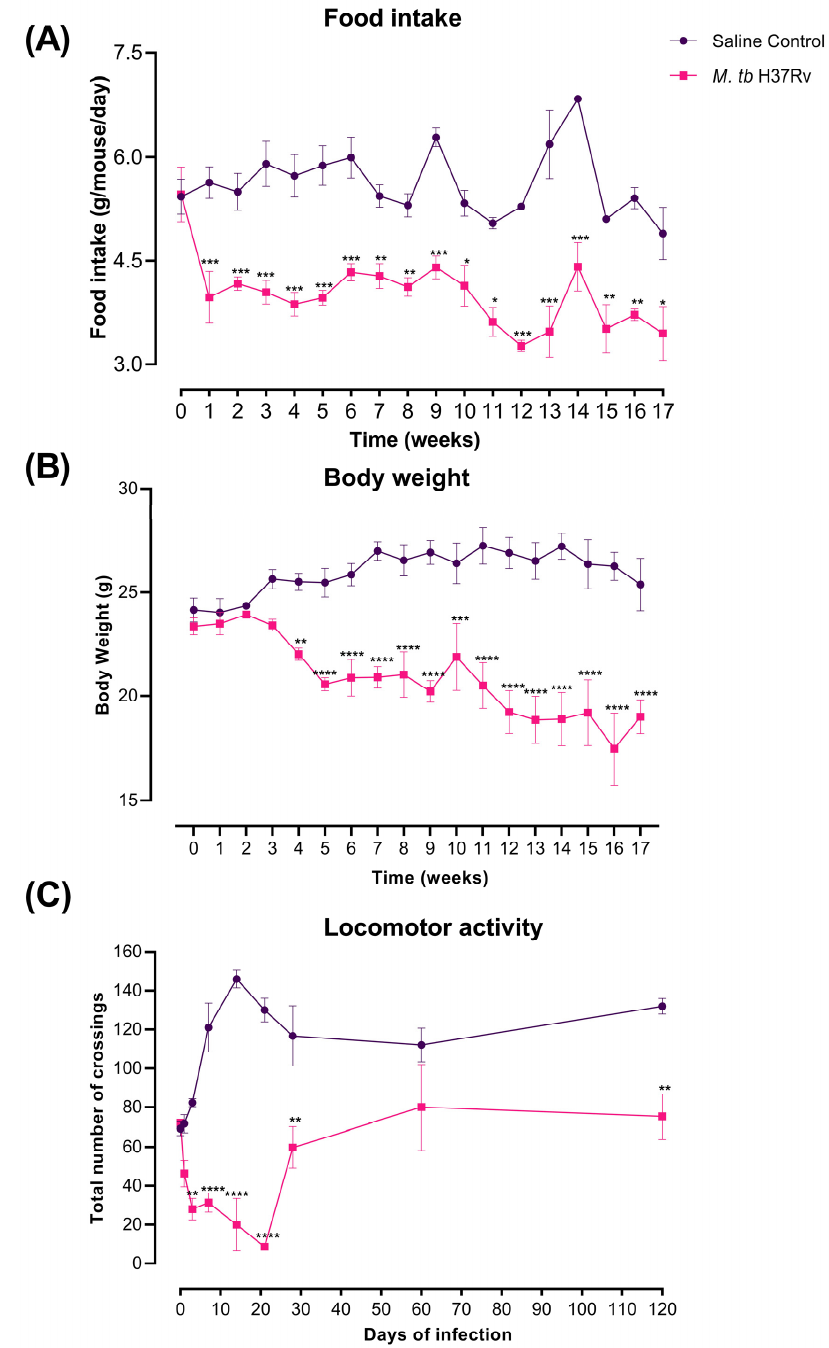
Figure 13. Sickness behaviour showed by TB mice. ( A ) Food intake, ( B ) body weight loss and ( C ) locomotor activity (LMA). Infected animals showed food intake decrease after one week of infection, Body weight starts decreasing after three weeks post-infection, and the locomotor activity was decreased during the whole course of the disease being most pronounced during early infection from day 1 to 21. Data are expressed as mean ± SEM. Food intake F (1, 10) = 51.86, p < 0.0001, two-way ANOVA; * p < 0.01, ** p < 0.001, *** p < 0.0005, Sidak’s multiple comparisons test ( α = 0.05) ( n = 6). Body weight loss F (1, 3) = 101.2, p = 0.0021, two-way ANOVA; ** p < 0.001, *** p < 0.0002, **** p < 0.0001, Sidak’s multiple comparisons test ( α = 0.05) ( n = 6). LMA F (1, 4) = 222.9, p = 0.0001, two-way ANOVA; ** p < 0.001, **** p < 0.0001, Sidak’s multiple comparisons test ( α = 0.05) ( n =